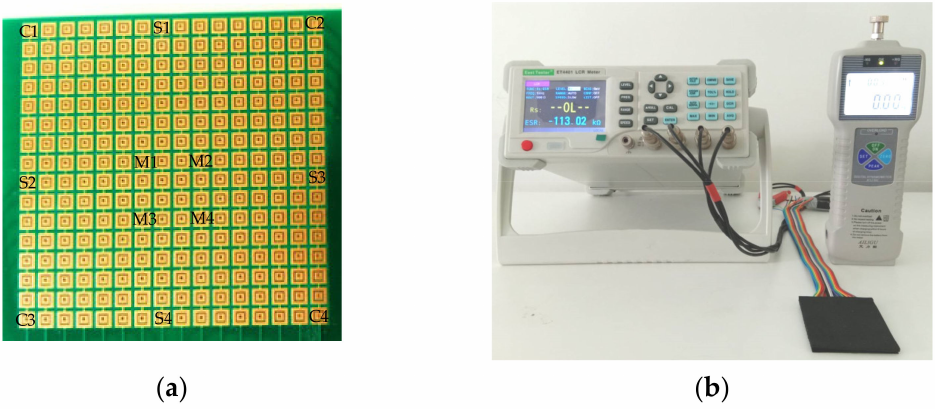
Figure 8. The sensor sensitivity measurement; ( a ) the sensor array with positions designated for testing; ( b ) the apparatus used for